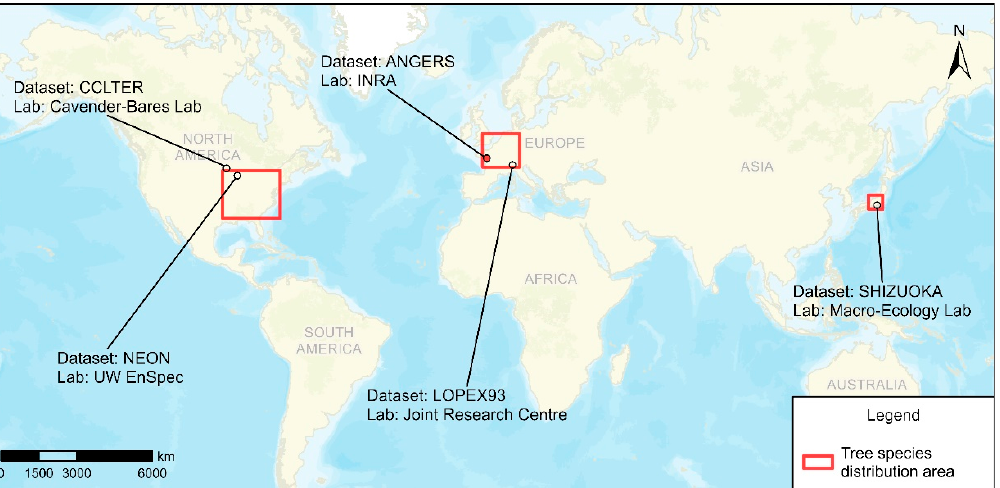
Figure 1. Data source and tree species distribution: ANGERS; LOPEX93; NEON; CCLTER; SHIZU- OKA.